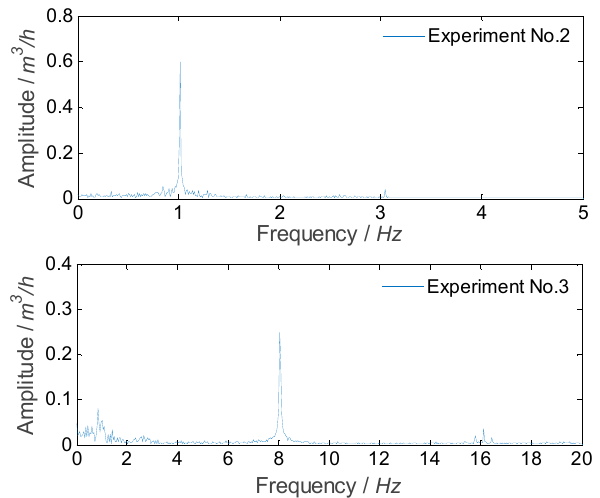
For experiment Nos. 2 and 3, the measured signal mainly consisted of three parts: sinusoidal fluctuation with a single frequency (1 Hz or 8 Hz), flow fluctuation of facility itself, and noise, as shown in Figure 12. When using the SVD method to obtain the flow fluctuation signal, the first two singular values and their corresponding vectors were selected to extract the sinusoidal fluctuation signal, and then the first 100 singular values in the remaining singular values and their corresponding vectors were selected to extract the fluctuation signal of the facility itself, and other singular values and their corresponding vectors that correspond to noise were deleted.